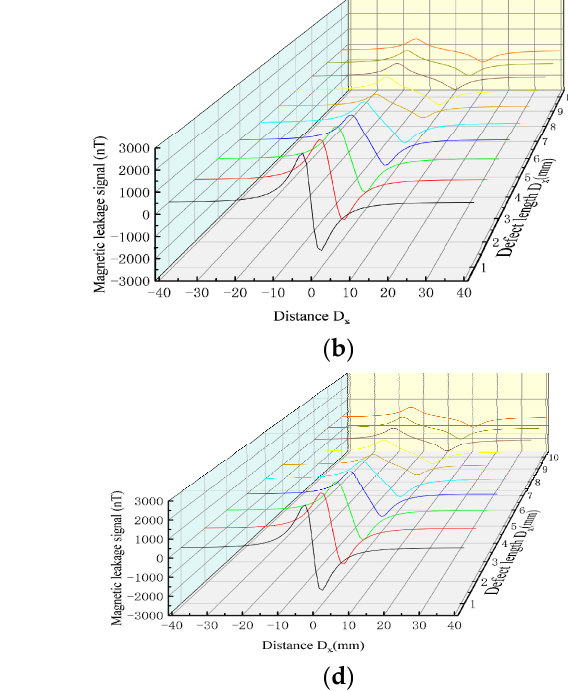
Figure 11. Positional relationship between magnetostriction and inflection point.